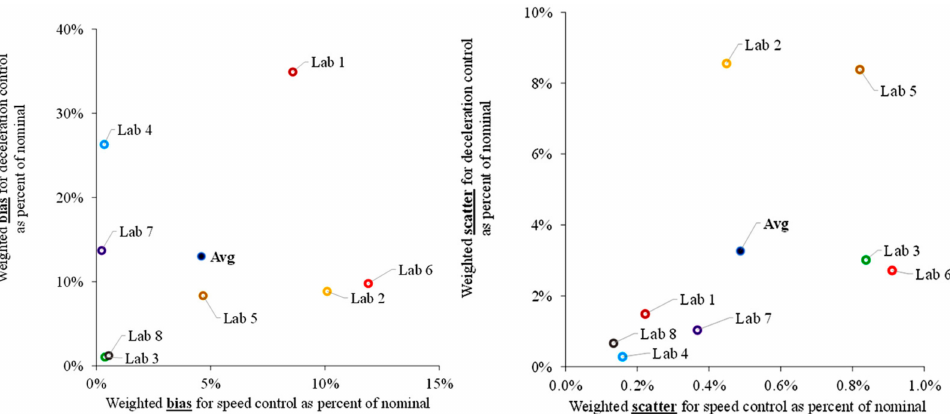
Figure 2. Plots for deceleration versus speed bias ( left-hand side ) and scatter ( right-hand side ) for all labs compared to the WLTP–brake